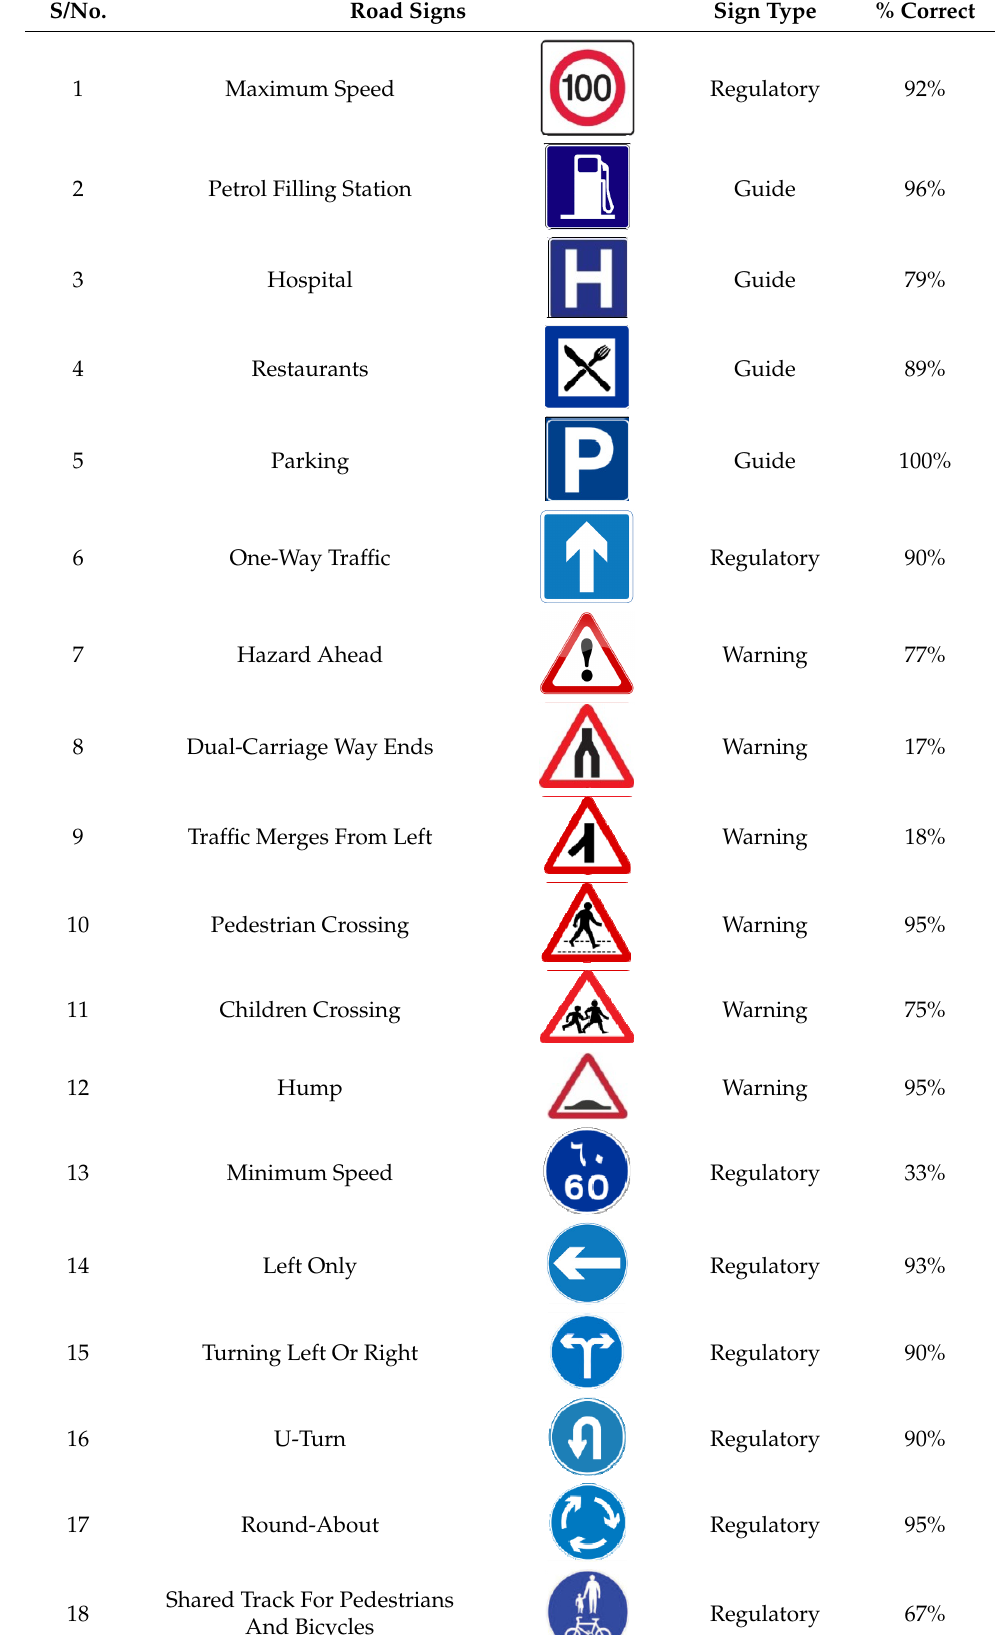
Table 7. Road sign comprehension performance. S/No. Road Signs